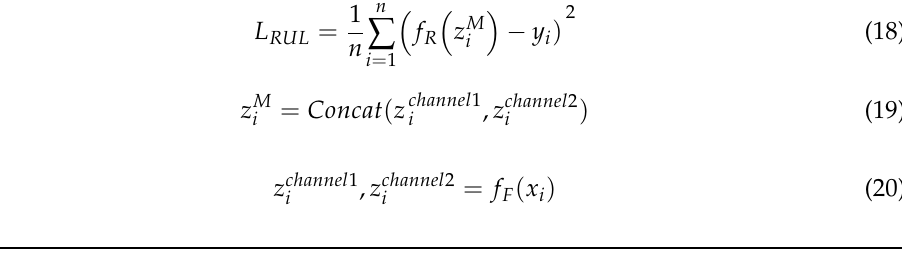
Algorithm 1. Description of algorithm